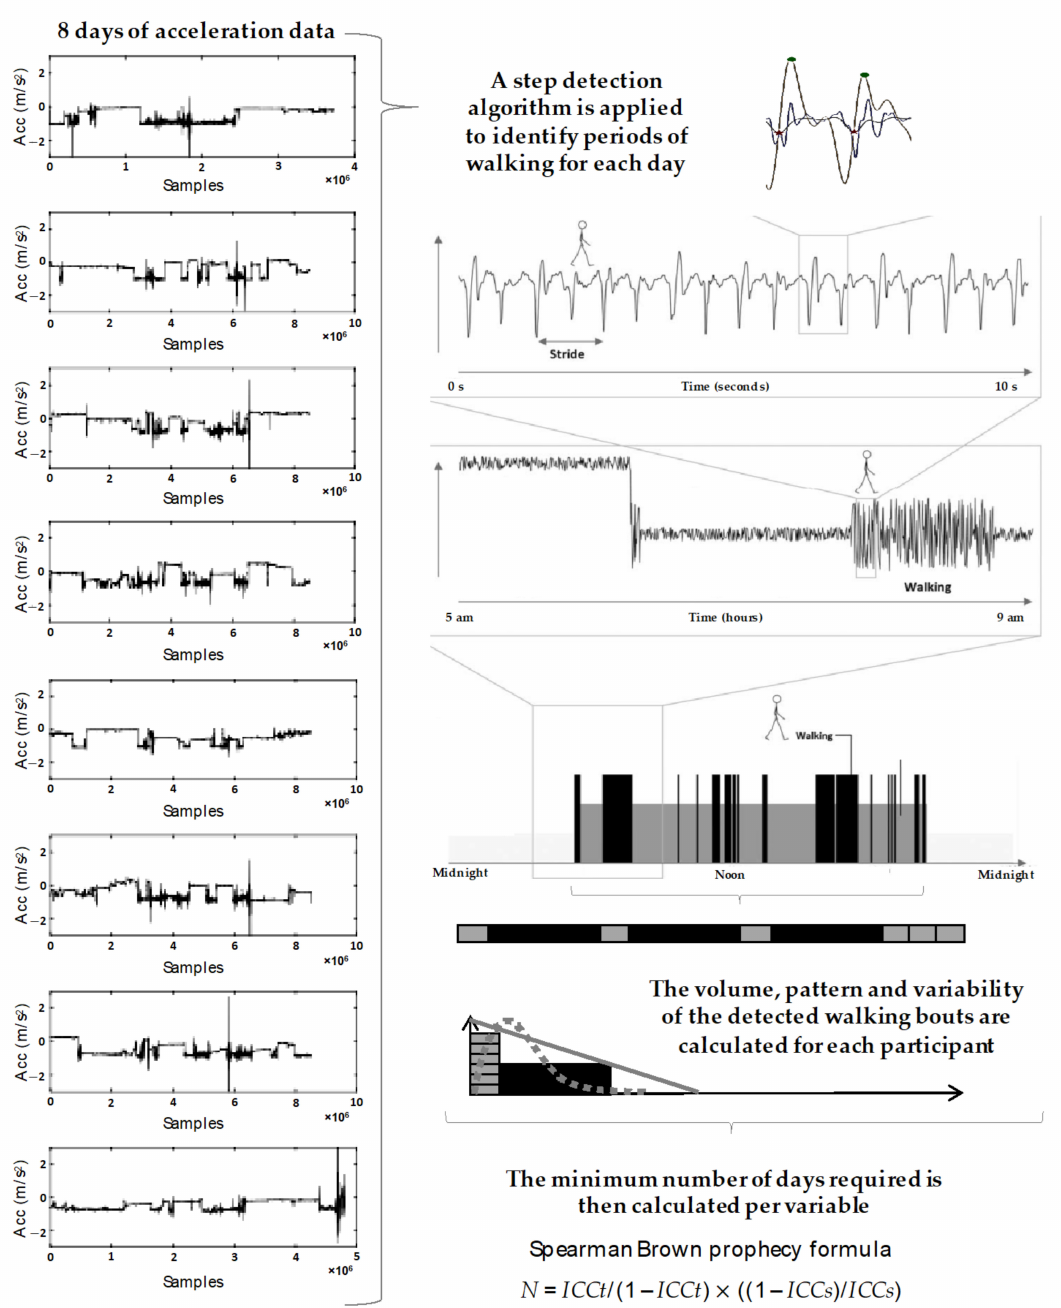
Figure 1. A flow diagram indicating the data processing pipeline, where 8 days of raw acceleration signal is refined to be included in the calculation of the minimum days required for each variable. Adapted with permission from